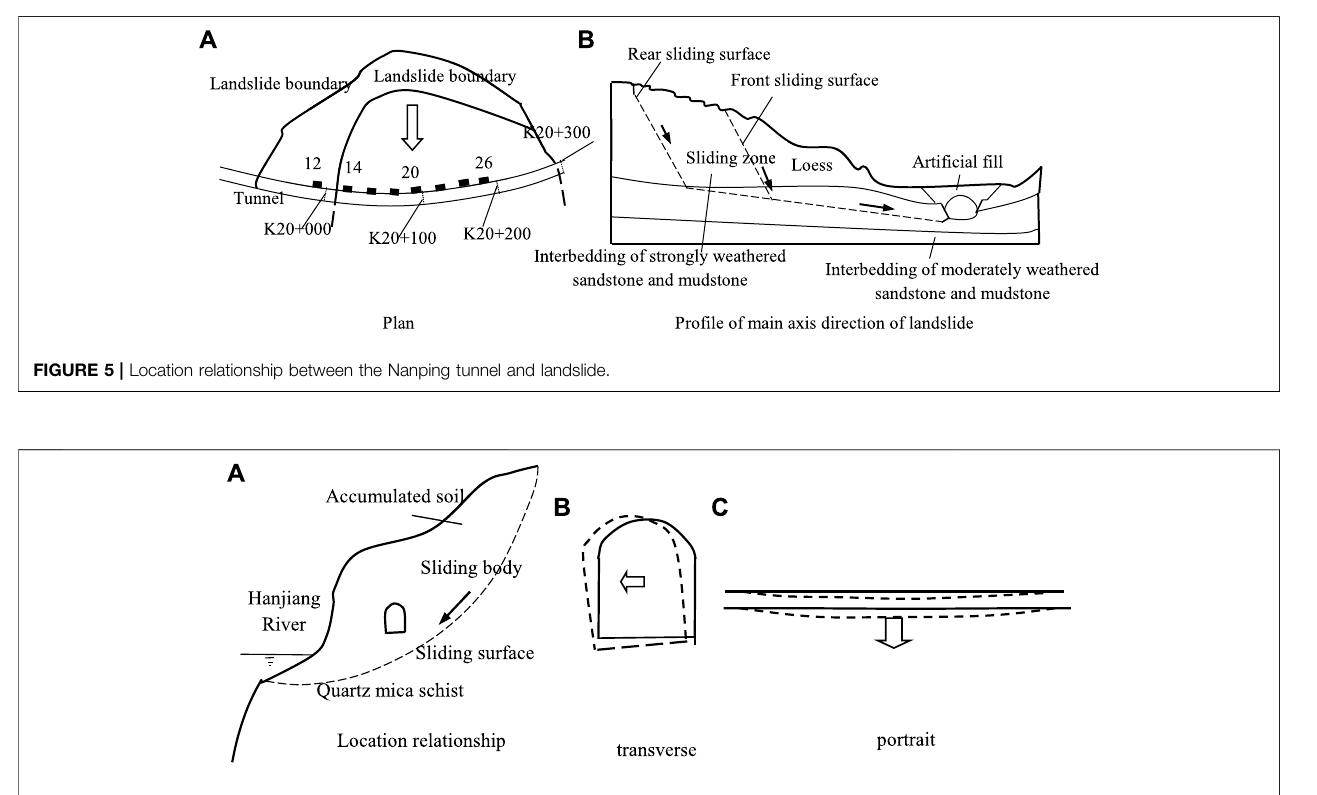
FIGURE 6 | Location relationship and deformation